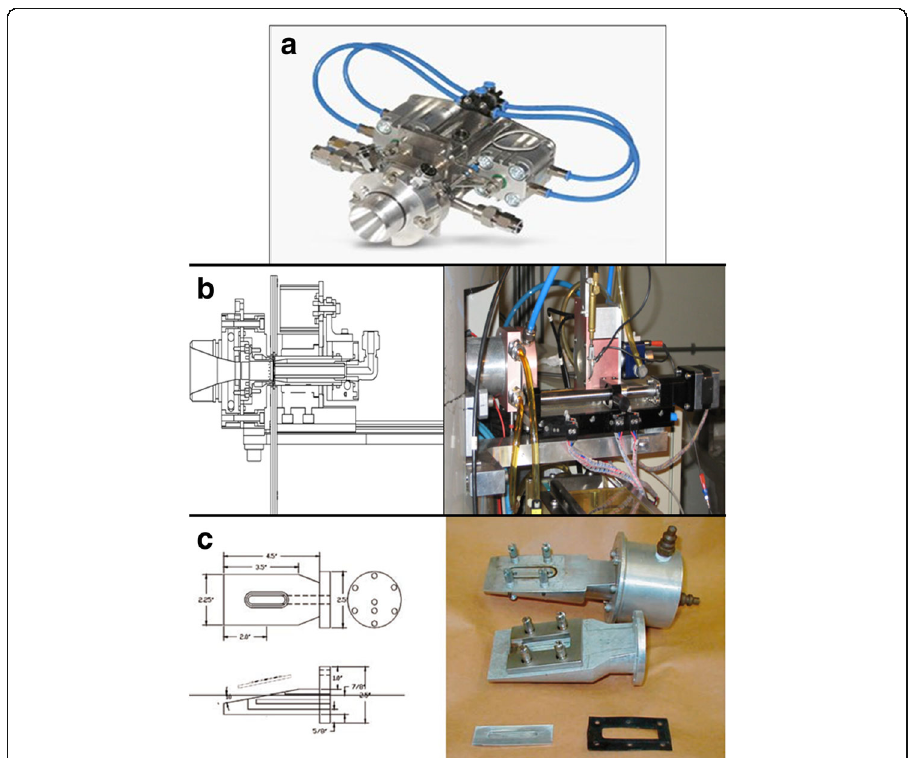
Fig. 2 Examples of solid targets. a COSTIS (Compact Solid Target Irradiation System) IBA Nirta target, b Custom developed Zirconium-89 target, images courtesy of Roel Mooij, BV Cyclotron VU, Amsterdam, NL c Custom developed inclined solid target, black line depicts beam direction from the cyclotron, cross section visualizes cooling channels (IAEA, Cyclotron Produced Radionuclides: Principles and Practice,